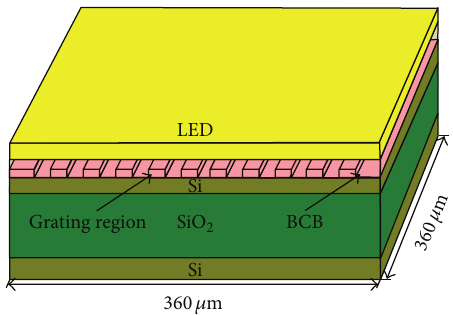
Figure 2: The proposed binary blazed grating structure.